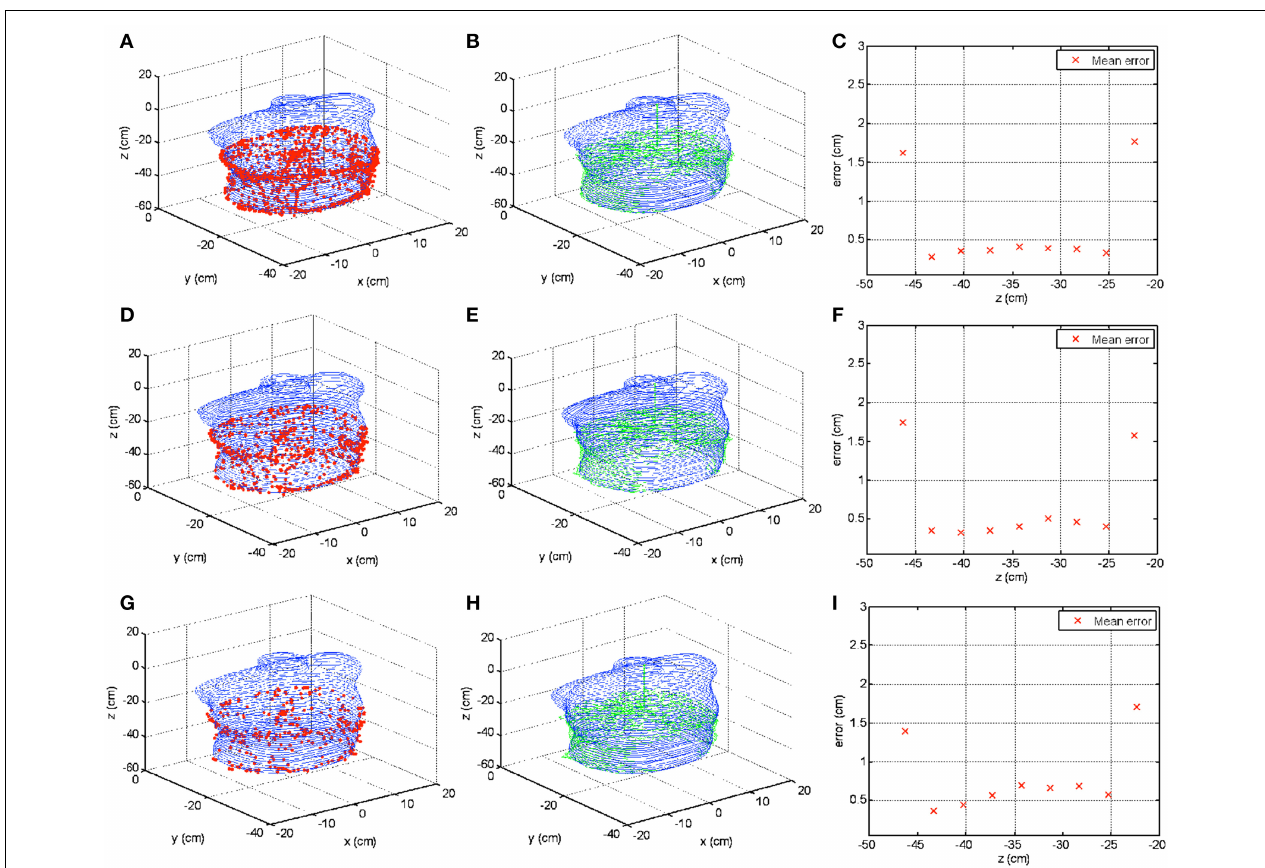
FIGURE 12 | Surface contour reconstructions from different numbers of raw contour data samples. (A–C) Show contour reconstruction results including raw contour data, contour reconstruction, and error calculation as a